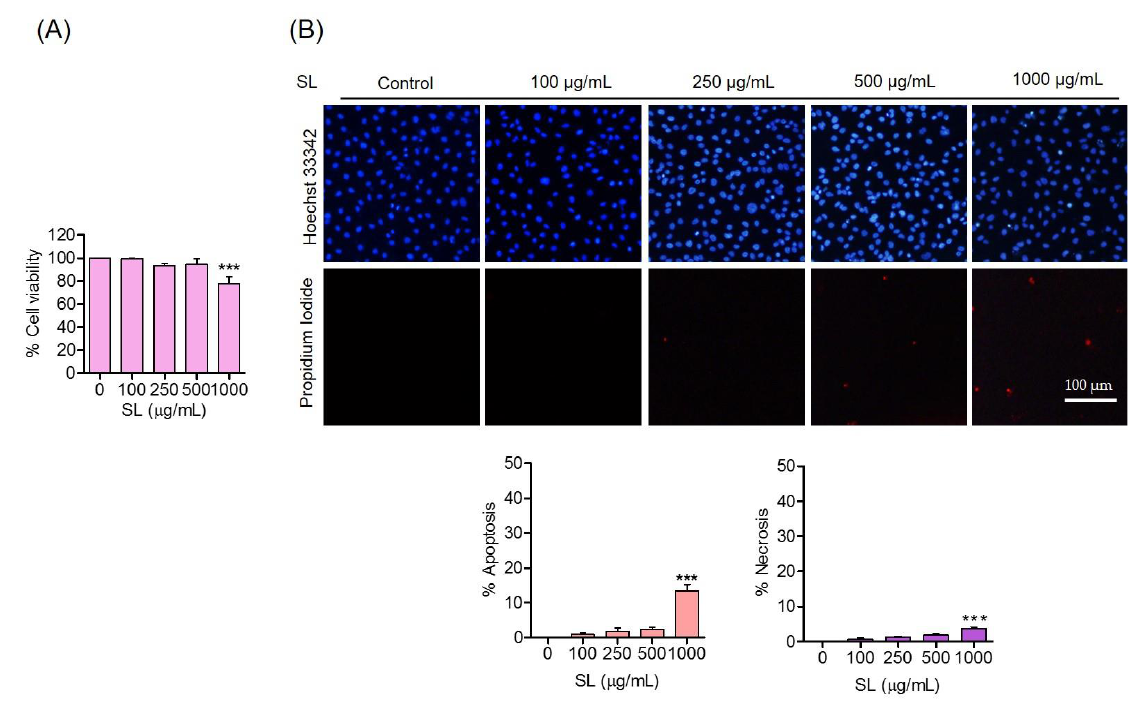
Figure 2. Cytotoxicity of SL on human endothelial cells. ( A ) Effect of SL on the cell viability of EA.hy926 cells at 24 h, evaluated by MTT assays. ( B ) Morphology of apoptotic or necrotic nuclei evaluated by Hoechst 33342 and propidium iodide (PI) co-staining, visualized using fluorescence microscopy and calculated for the percentages of apoptosis and necrosis cells. Data are presented as mean ± SD ( n = 3). Significant compared with the control group, *** p < 0.001 versus the non-treated control.